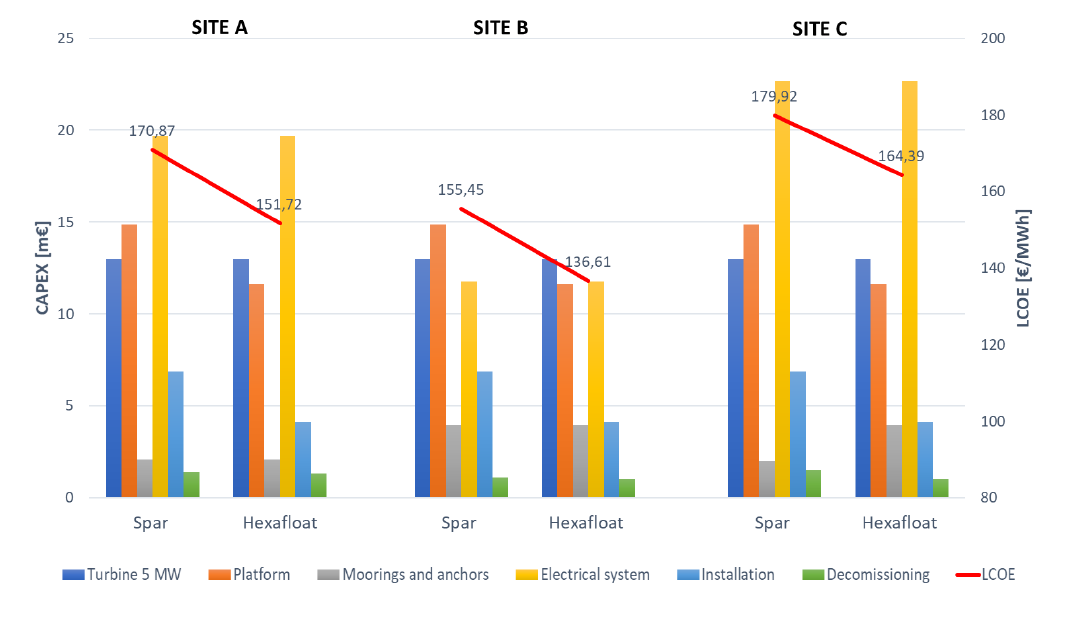
Figure 17. Capex and LCOE for sites A, B, and C, considering spar-buoy and Hexafloat optimized